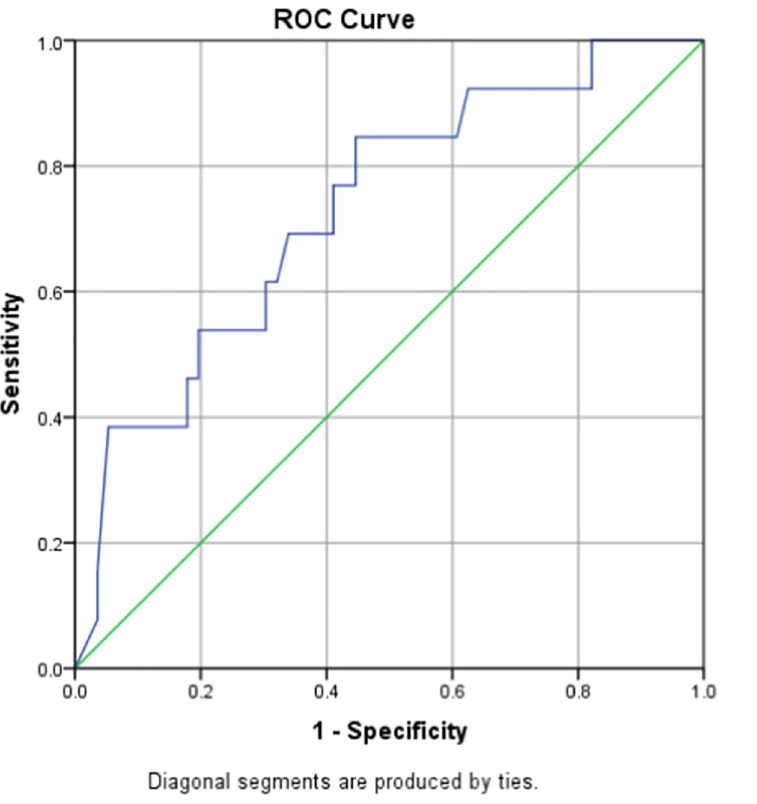
Fig 3. ROC curve for D-dimer as a predictor of in-hospital mortality in females.